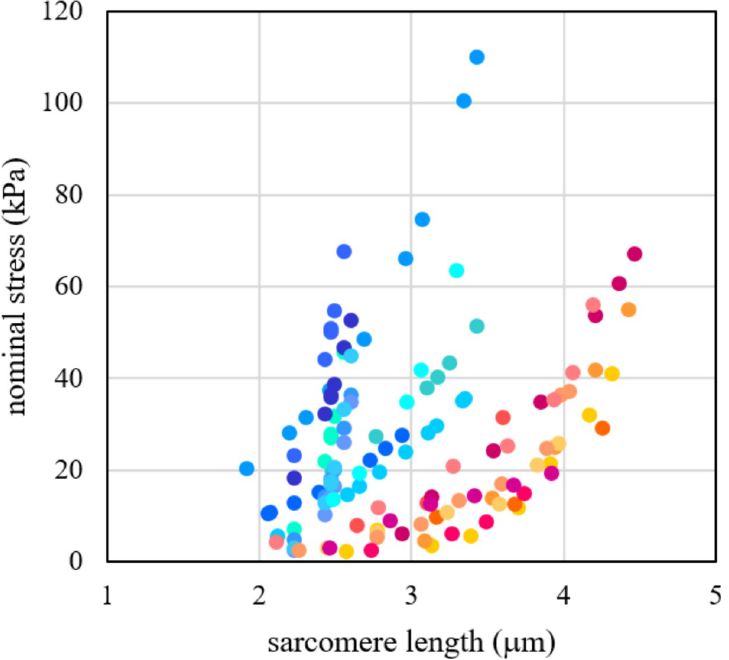
Fig 3. Bundle stress vs. sarcomere length. Stress vs. sarcomere length experimental data for passive elongation of single fibres and bundles. Fast and slow fibres are grouped together for comparison. Red tones are for fibres, blue ones for bundles (different colour for each